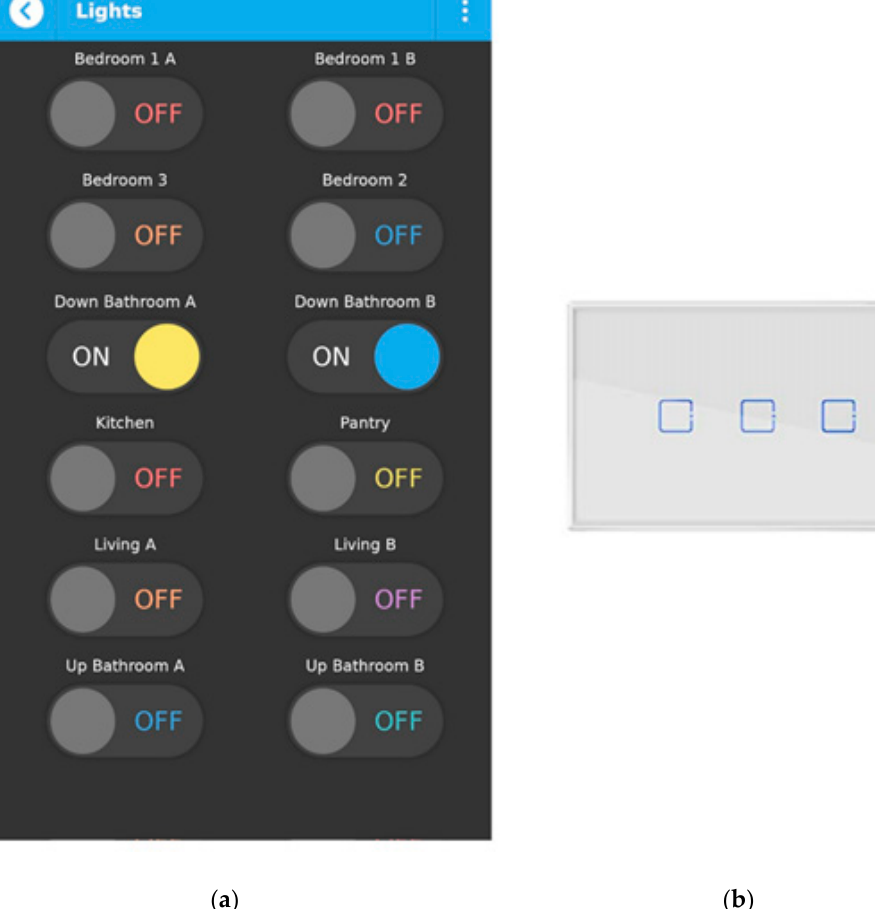
Figure 9. Switching on and off the lights in a house with qToggle app ( a ) and the Sonoff Touch device ( b ).